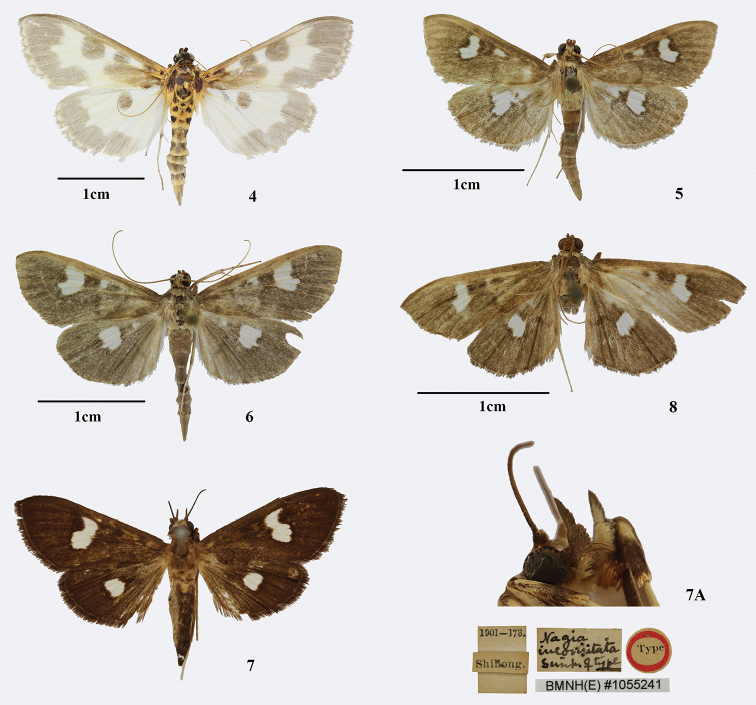
Habitus of Nagiella species 4N.
hortulatoides male 5N.
inferior male 6N.
quadrimaculalis male 7Nagia
incomitataSwinhoe 1894 female, type, BMNH Pyr., London. 7A head 8Nagiella
bispina sp. nov. male, holotype.